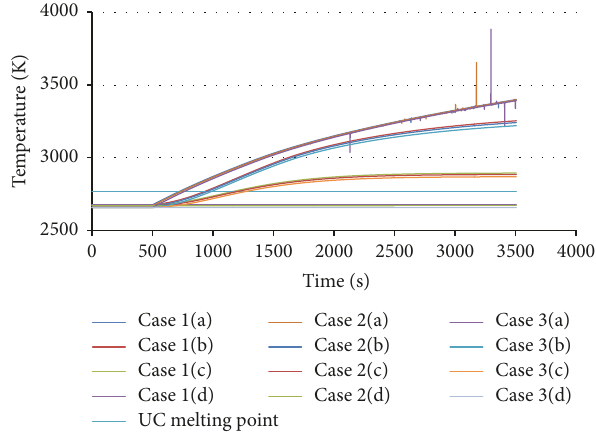
Figure 13: Temperature of fuel elements.